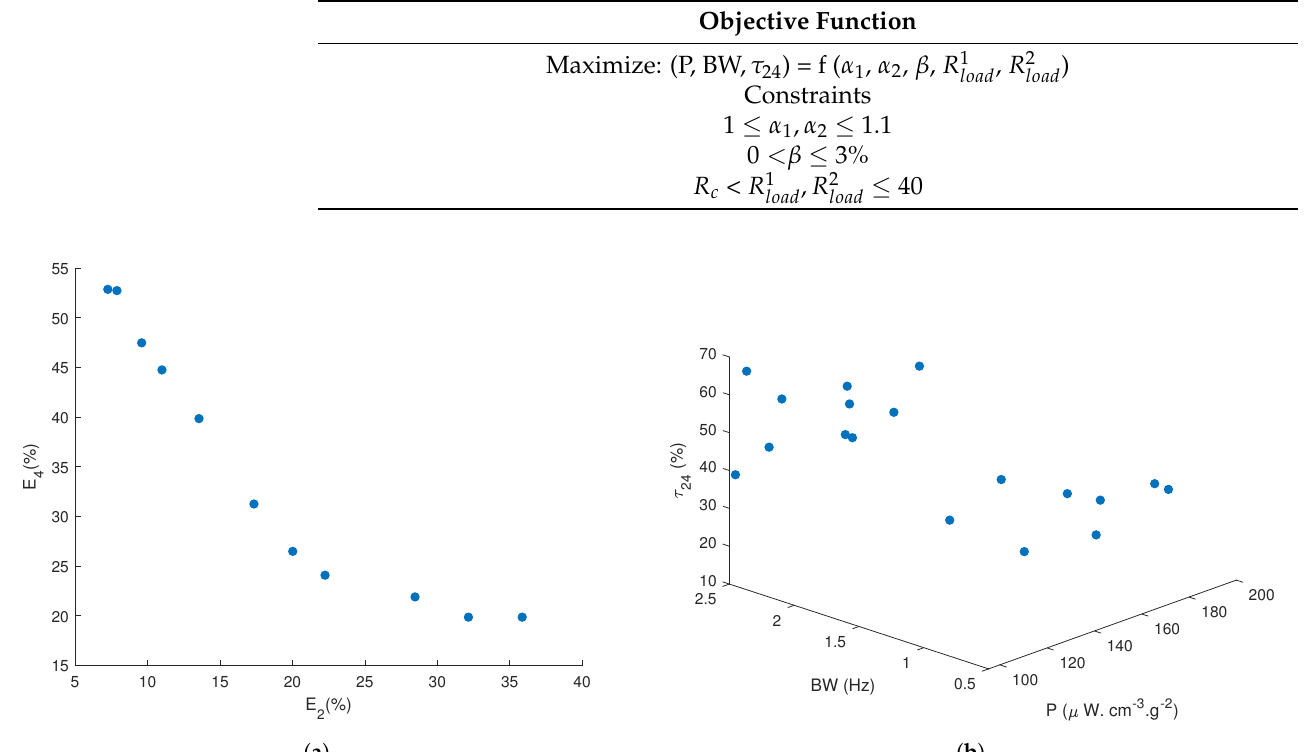
Figure 7. ( a ) Pareto front of the 5-DOFs system: E 2 versus E 4 . ( b ) Pareto front of the 5-DOFs system: frequency bandwidth versus harvested power with the corresponding energy localization rates in %.